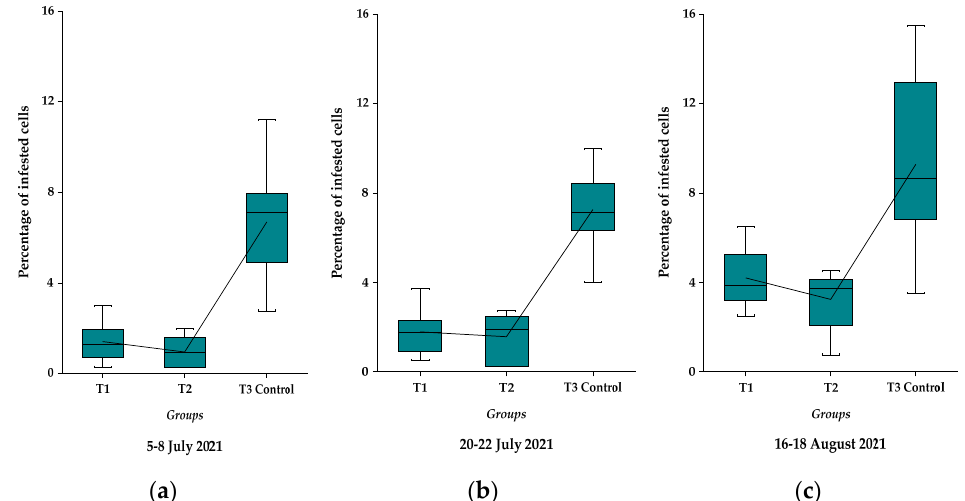
Figure 2. The box plotted data on the percentage of varroa mite infested cells evaluated in different